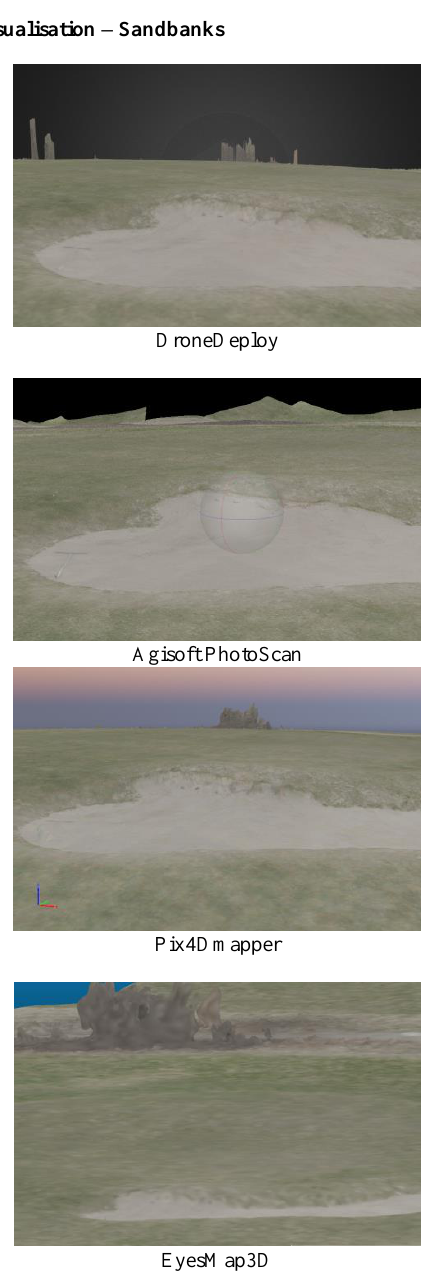
Figure 4. 3D models generated for sandbanks